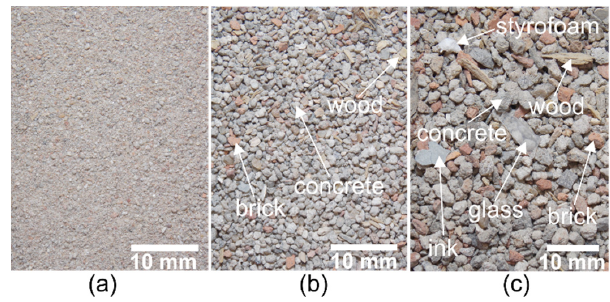
Figure 1. Construction and demolition waste (CDW) granulometry ( a ) fine; ( b ) medium; and ( c )